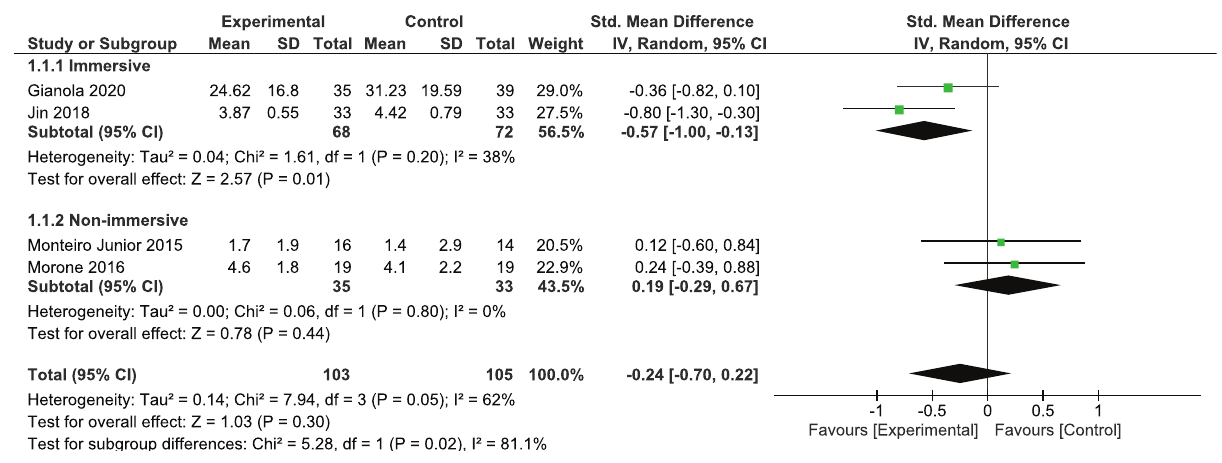
Dropouts varied across studies and interventions ( Figure 6